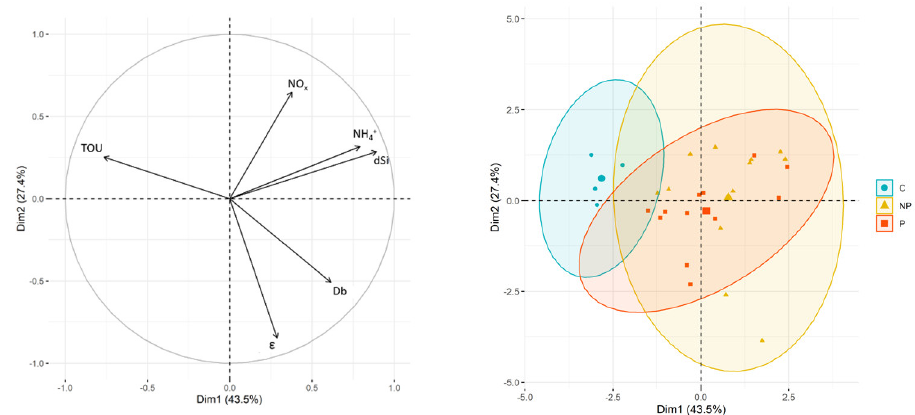
Figure 4. Principal component analysis (PCA) of standardized data. Black arrows represent the projection of measured variables (sediment reworking rates (Db), bioirrigation rates (ε), total oxygen uptake (TOU), and ammonium (NH 4+ ), nitrates and nitrites (NO x ), and silicate (dSi) fluxes) on the first plane of the PCA. Points correspond to experimental units including the three treatments (“control” treatment (C) in the blue circle, “nonparasitized” cockles (NP) in the yellow triangle, and “parasitized” cockles (P) in the red square). Larger points represent the gravity center of each group corresponding to a treatment, and lines show the confidence ellipse at the 0.95 level.